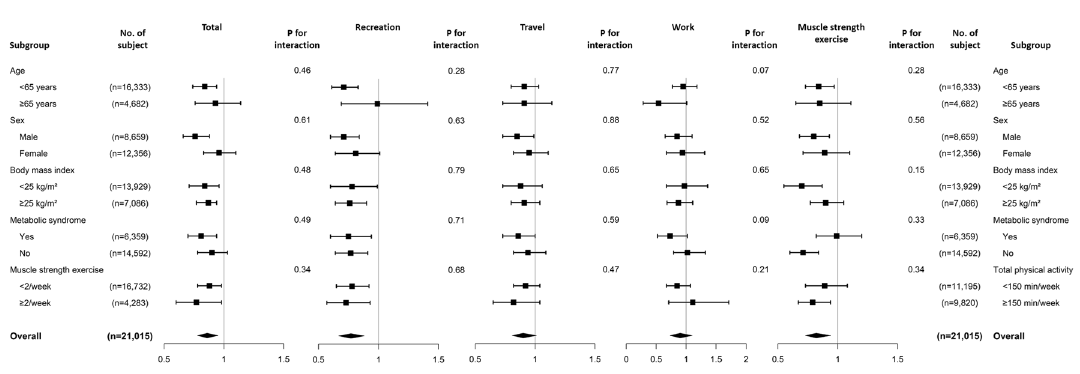
Figure 4. Odds ratio for the risk of NAFLD by the level of physical activity (< 150 min/week vs. ≥ 150 min/ week) or muscle strength exercise (< 2/week vs. ≥ 2/week) in predefined subgroups. Models were adjusted for age (continuous), sex, body mass index (continuous), elevated waist circumference (yes vs. no), elevated triglycerides (yes vs. no), reduced high-density lipoprotein cholesterol (yes vs. no), diabetes mellitus (yes vs. no), hypertension (yes vs. no), income levels (Q1, Q2, Q3, and Q4), education (elementary or lower, middle school, high school, college or higher), smoking (current, ex-smoker, and never smoker), alcohol consumption (< 10 g/ day vs. 10 g/day), total physical activity (< 150 min/week vs. ≥ 150 min/week), and muscle strength exercise (< 2/week vs. ≥ 2/week). For specific domains of physical activity, other domains were adjusted as follows: (1) For recreation activity, travel and work activities (< 150 vs. ≥ 150 min/week) were adjusted; (2) For travel activity, recreation and work activities (< 150 vs. ≥ 150 min/week) were adjusted; and (3) for work activity, recreation and travel activities (< 150 vs. ≥ 150 min/week) were